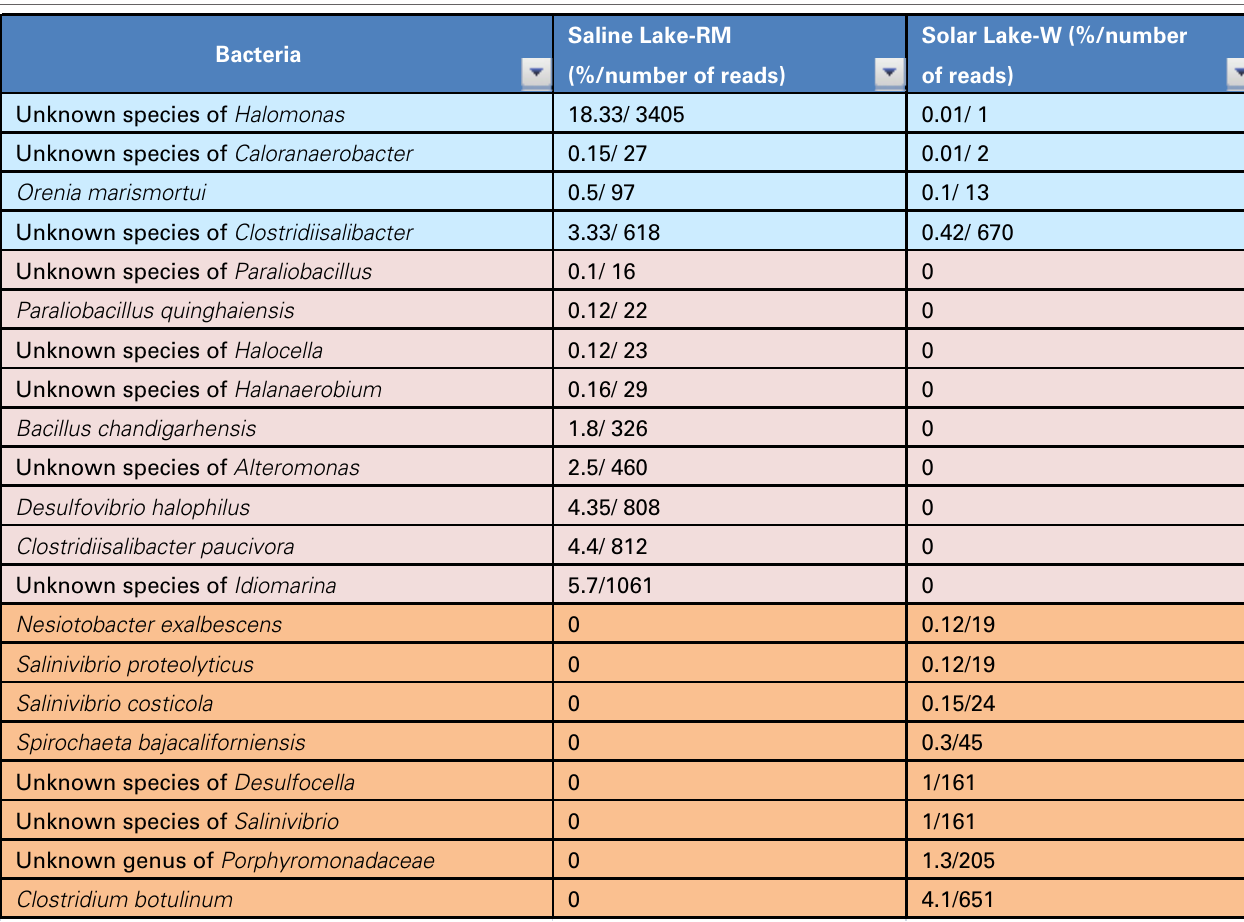
Table 5 | Bacteria identified only in the two